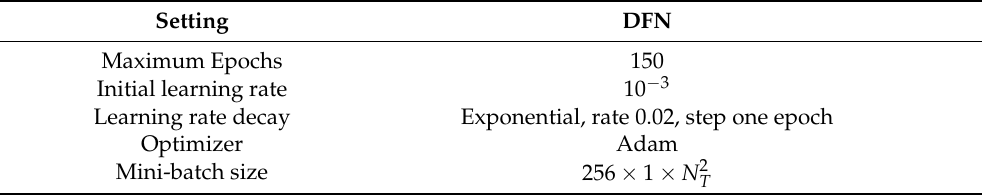
Table 1. DFN hyperparameters. Setting DFN Maximum Epochs